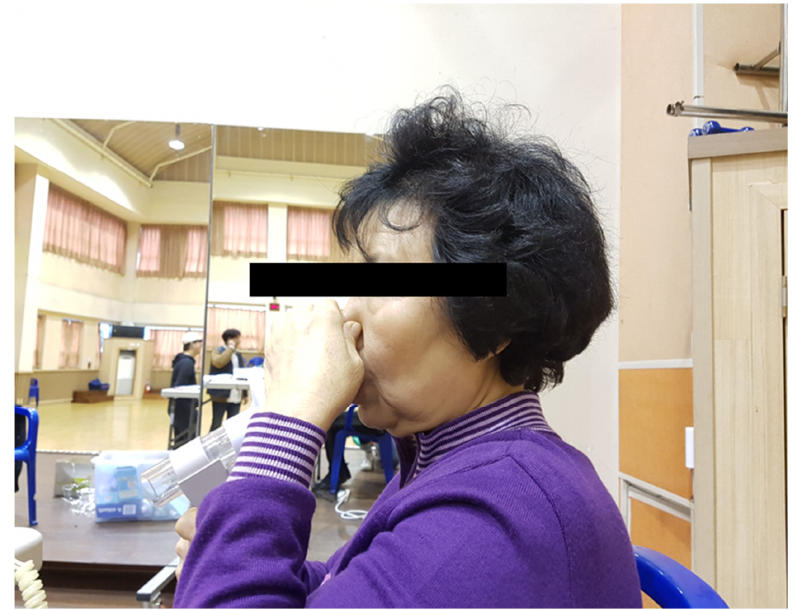
Figure 3. Pulmonary function